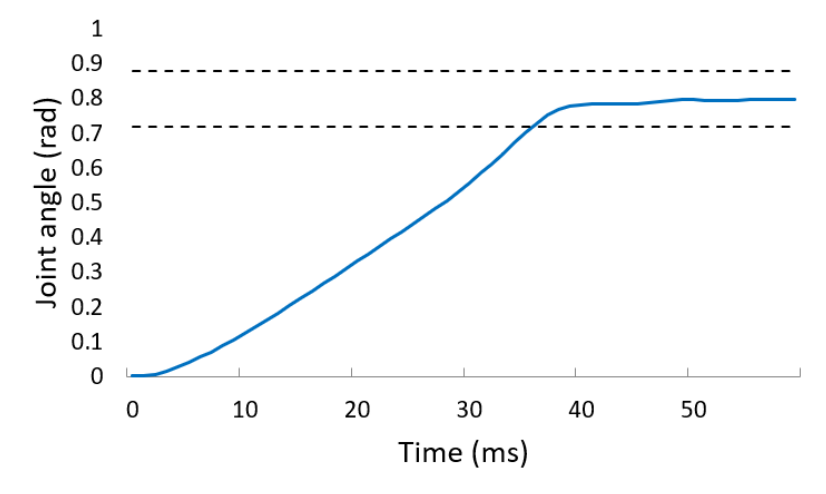
Figure 14. Joint response of high-speed robot hand.